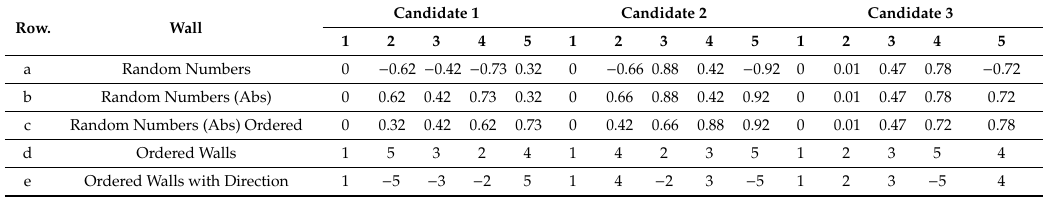
Table 1. Creation of three candidate vectors for a sample problem. Absolute values in rows b and c.